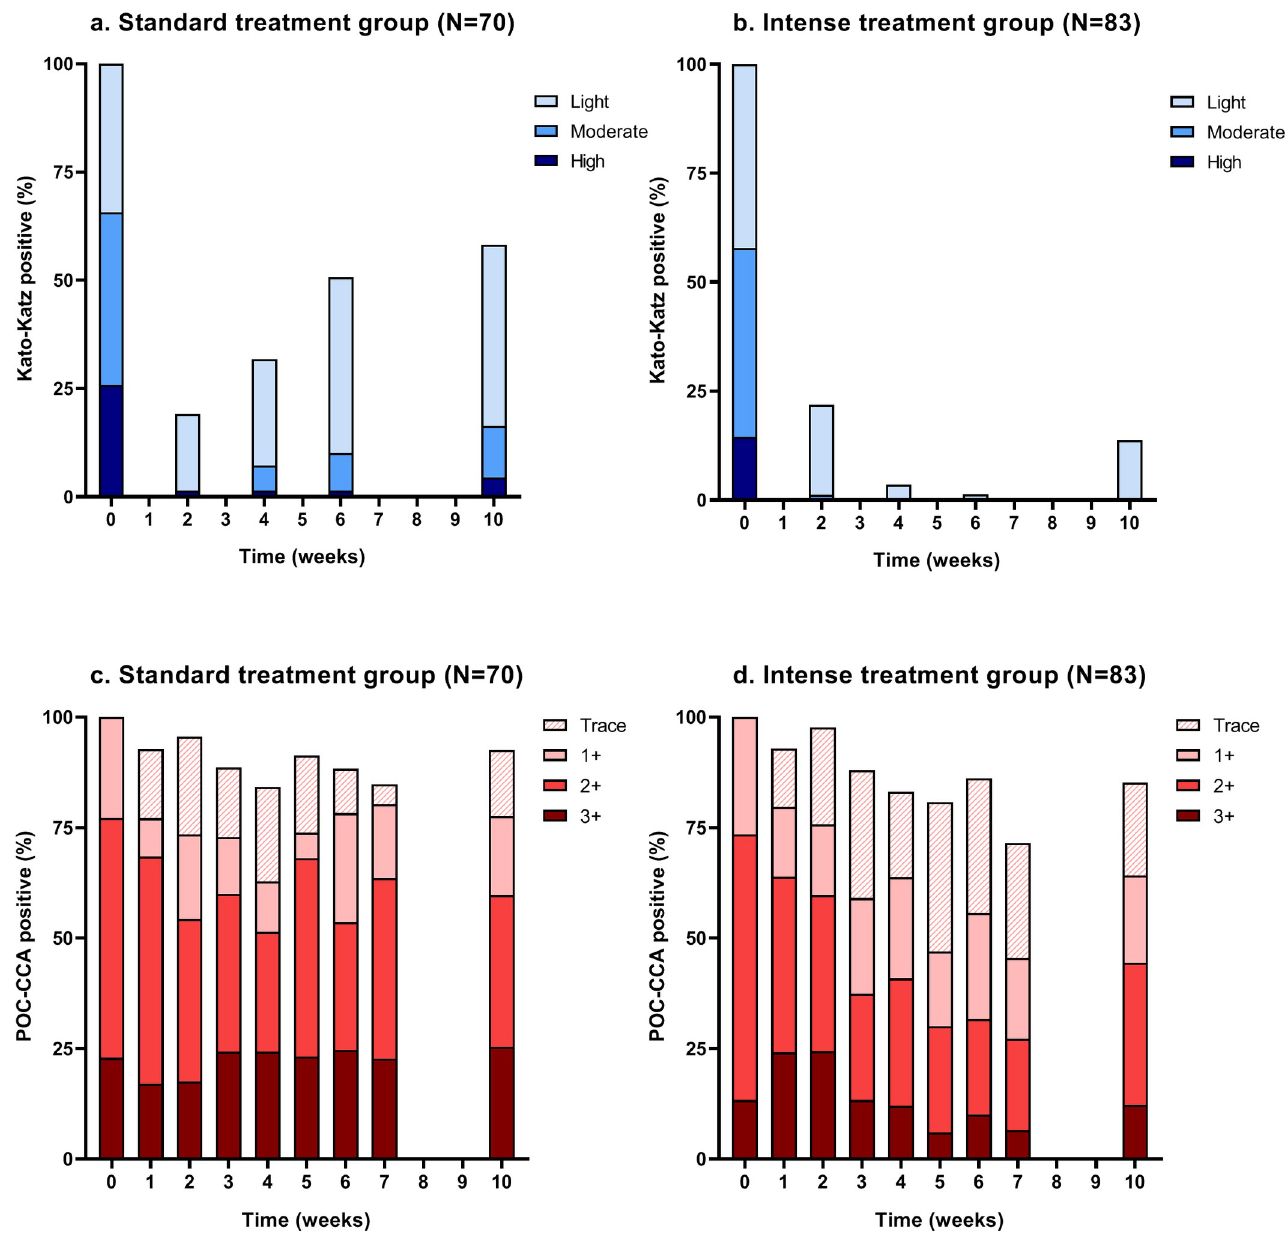
Fig 3. Intensity of infection. Data are based on triplicate Kato-Katz (KK) thick smears from a single stool sample (a, b) and single point-of-care circulating cathodic antigen (POC-CCA) urine test (c, d) in the standard treatment group (single dose of PZQ) and the intense treatment group (four doses of PZQ at W0, W2, W4, and